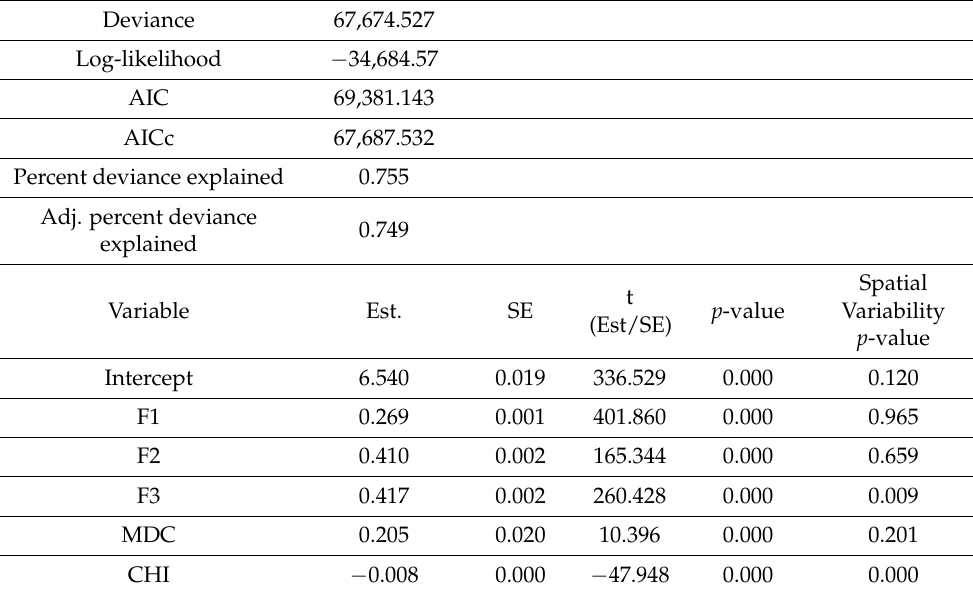
Table 2. Global regression results, test statistics of predictor variables, and results of the Monte Carlo test for spatial variability.